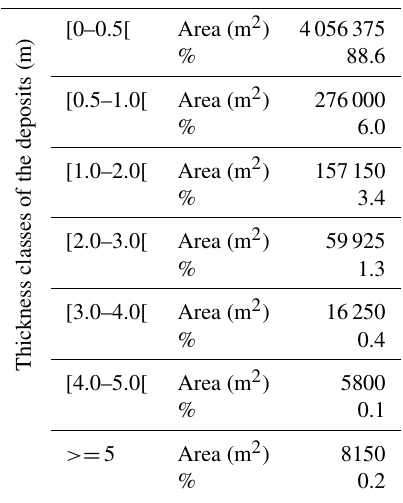
Table 7. Classification of the deposits thickness and occupied area (Scenario A).